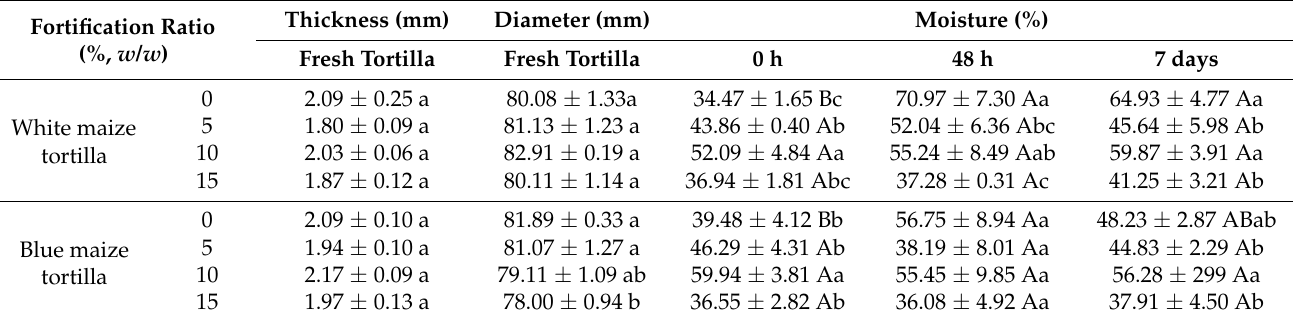
Table 3. Thickness and diameter of fresh tortillas and moisture over storage time of tortillas fortified at different ratios with optimized chickpea hydrolysate with DPPIV inhibitory activity obtained from isolated protein using bromelain.